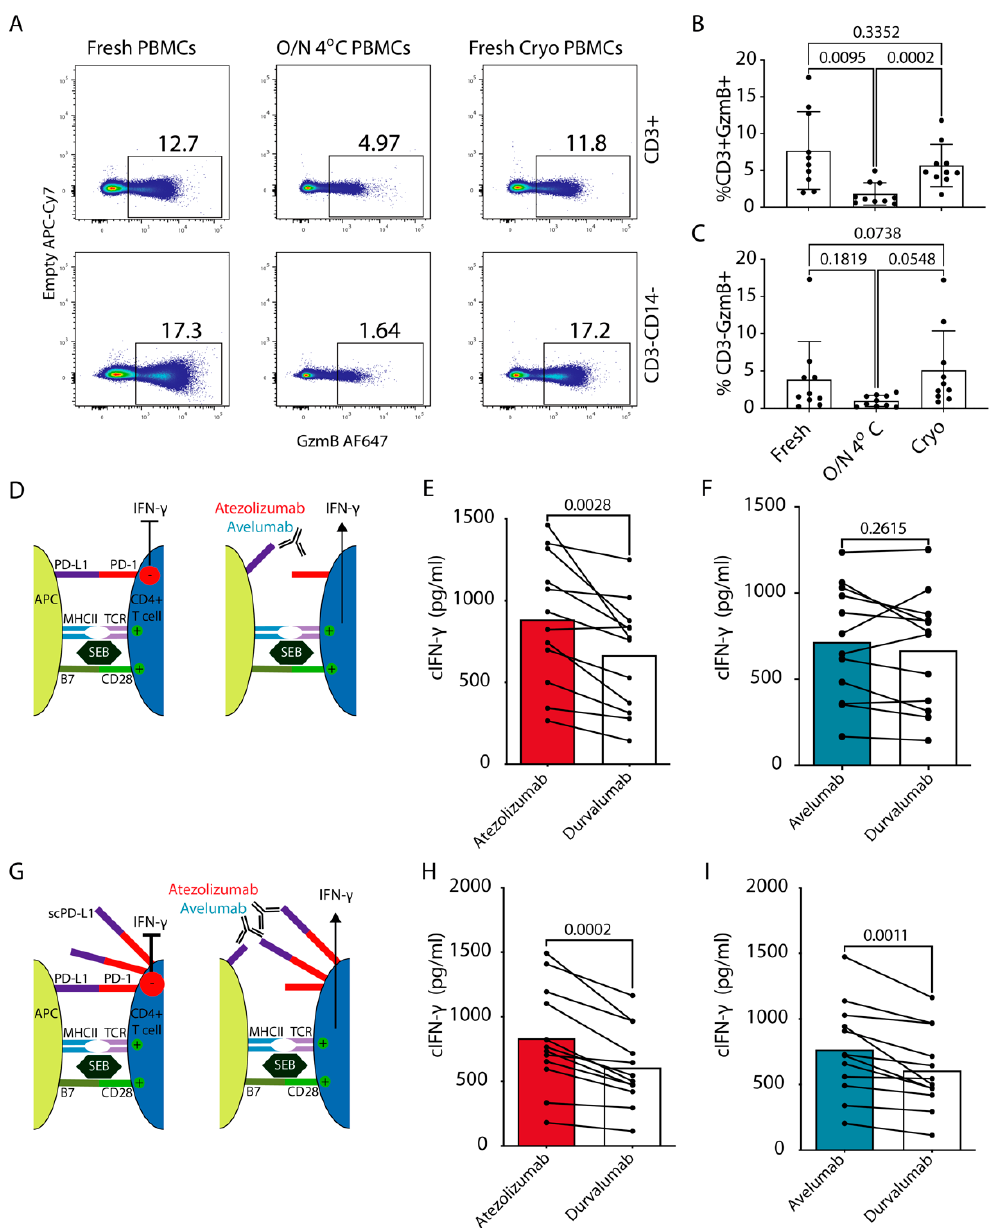
Figure 3. Functional effects of cPD-1/L1 blockade on cIFN- γ production by cPBMCs. ( A – C ) Flow cytometric analysis of GzmB production by canine NK and T cells for freshly isolated PBMCs, PBMCs isolated after overnight (O/N) storage of whole blood at 4 ◦ C and freshly isolated, cryopreserved and thawed PBMCs. ( A ) Representative flow cytometric plots depicting gating for T cells (CD3+CD14 − ) and non-monocytes or T cell fraction, which contains canine NK cells (CD3 − CD14 − ). ( B , C ) Bar graphs showing percentages of GzmB producing cells in ( B ) T cells ( C ) NK cell containing fraction (representative plots from three independent experiments, Mean, SEM, Paired One-way ANOVA, n = 10). ( D , F ) Dog peripheral blood mononuclear cells ( n = 12, Table 2) were obtained from healthy donors and stimulated with 50 ng/mL of SEB in the presence of 10 µ g/mL of atezolizumab or avelumab. Durvalumab was used as a non-binding isotype (hIgG1) control antibody. ( G – I ) SEB stimulation as in D–F with addition of 10 µ g/mL of scPD-L1 [9] ( D,G ) schematic outlines of the experiments for ( E , F ); ( H , I ), respectively. For evaluation of cIFN- γ production, the culture supernatant was harvested on day 3, and measured by ELISA. Pooled data from 2 independent experiments (Paired Student’s t test with p values indicated on the